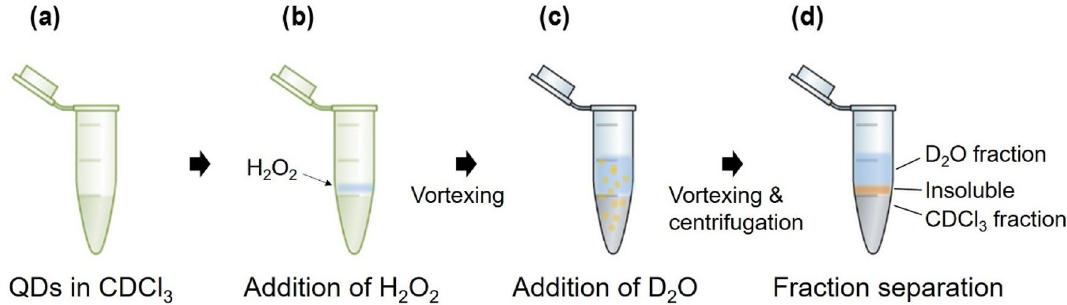
Figure 2. The ligand analysis procedure involving the use of H 2 O 2 as a heterogeneous oxidizing agent. First, the QDs dispersed in CDCl 3 ( a ) are treated with H 2 O 2 ( b ) and vortexed vigorously. Green color originating from the QDs is retained until step ( b ). Upon reaction under ambient condition, the sample loses its green color, leading to an insoluble layer (precipitate). In order to separate the fraction containing organic ligands from that containing H 2 O 2 and H 2 O, D 2 O is added to the sample, and the sample is again vortexed vigorously ( c ). Subsequently, the sample is separated into three fractions via centrifugation: the D 2 O fraction, insoluble fraction, and CDCl 3 fraction ( d ). The final soluble fractions are transparent and colorless.